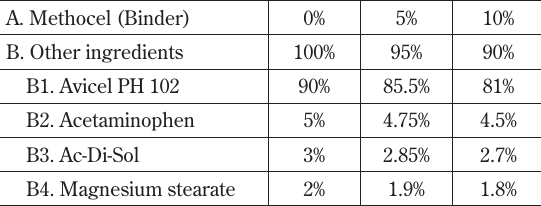
Table 2 Ingredients and their proportions used